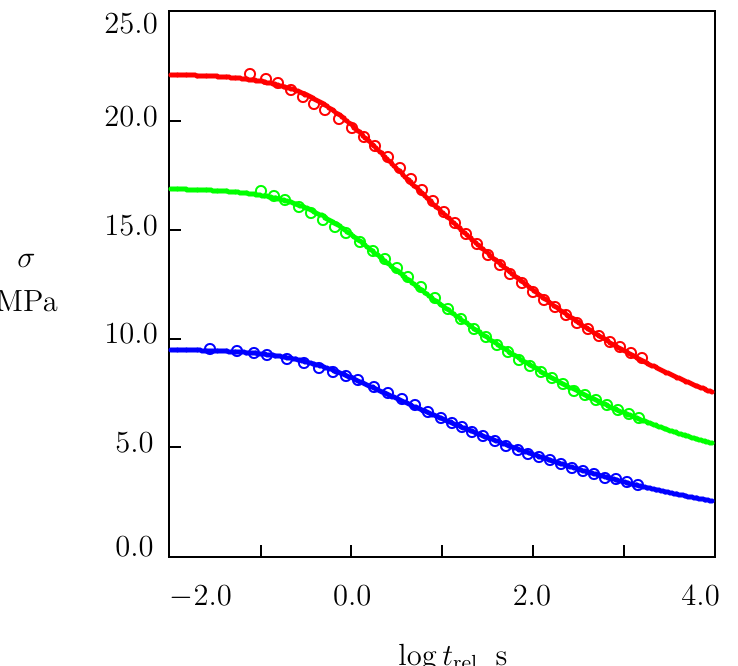
Figure 2. Tensile stress σ versus relaxation time t rel . Circles: experimental data in relaxation tests with Figure 2: Tensile stress σ versus relaxation time t . Circles: experimental data in relaxation various strains (cid:101) ( (cid:101) = 0.01—blue, (cid:101) = 0.02—green, (cid:101) = 0.05—red). Solid lines: results of rel tests with various strains (cid:15) ( (cid:15) = 0 . 01 – blue, (cid:15) = 0 . 02 – green, (cid:15) = 0 . 05 – red). Solid lines: results of simulation.